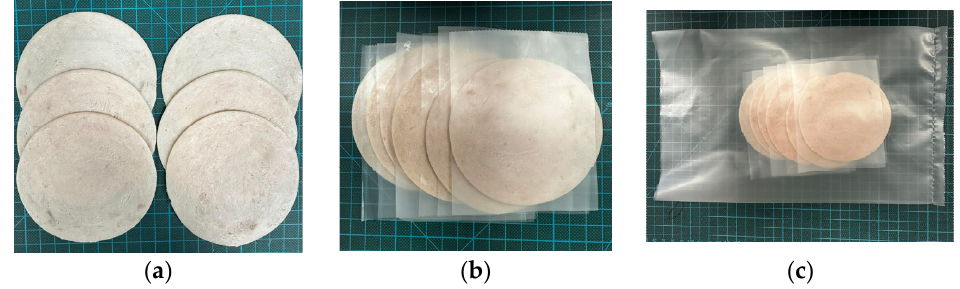
Figure 1. The sliced chicken sausage ( a ) “0” samples; ( b ) “0” samples separated with spacers; ( c ) the samples inside the package before storage.